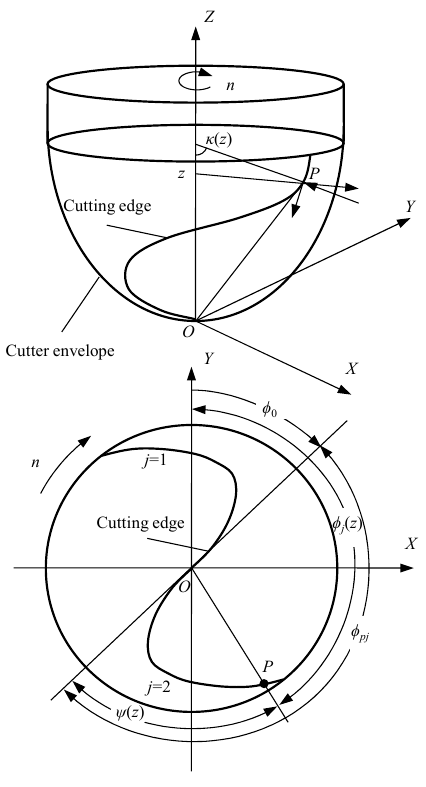
Figure 1. Geometry model of ball-end milling cutter.